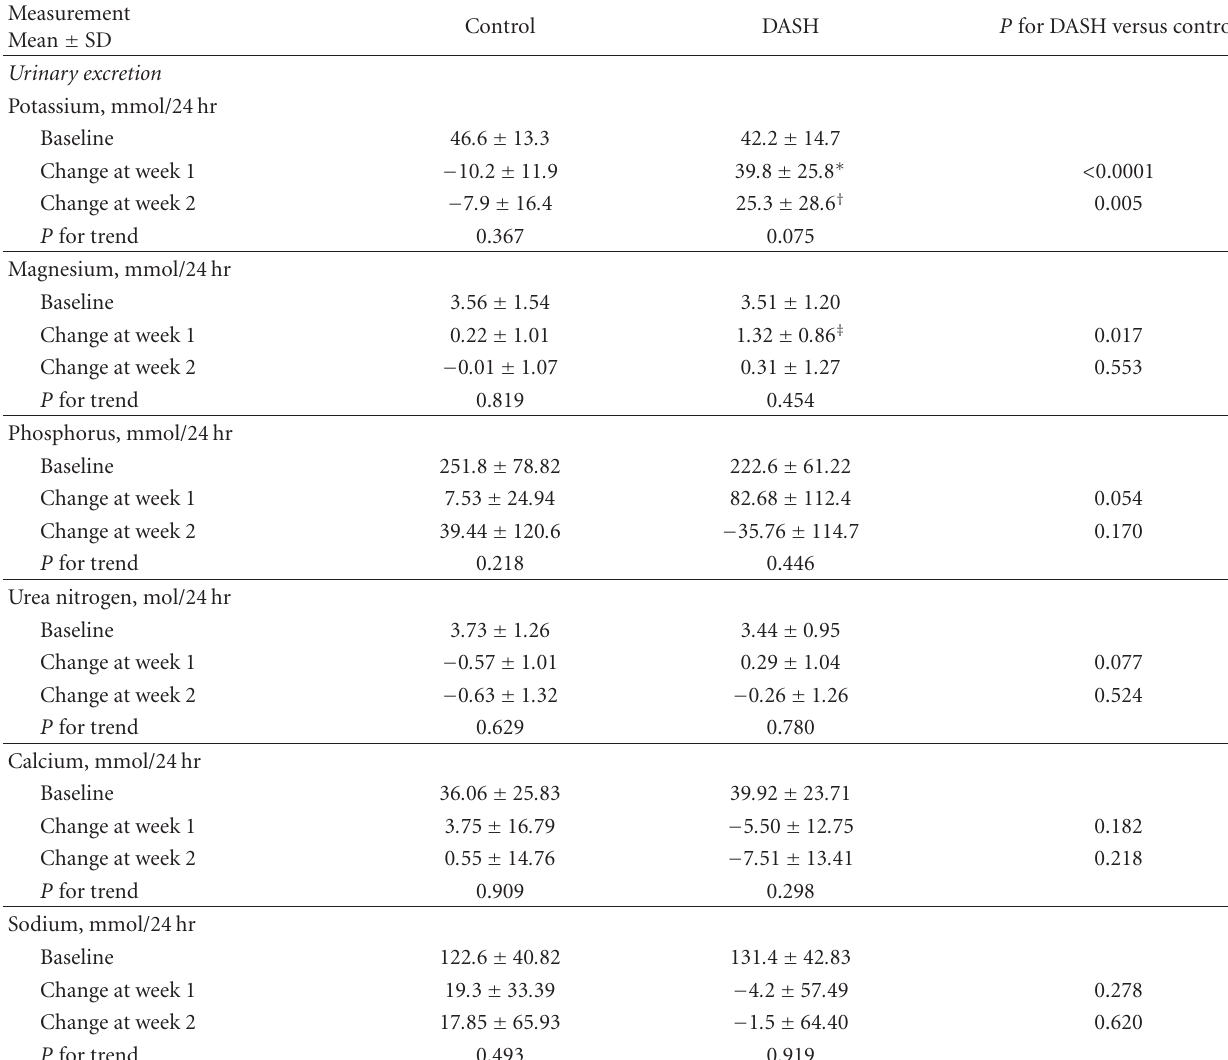
Table 3: Adherence measures by treatment and